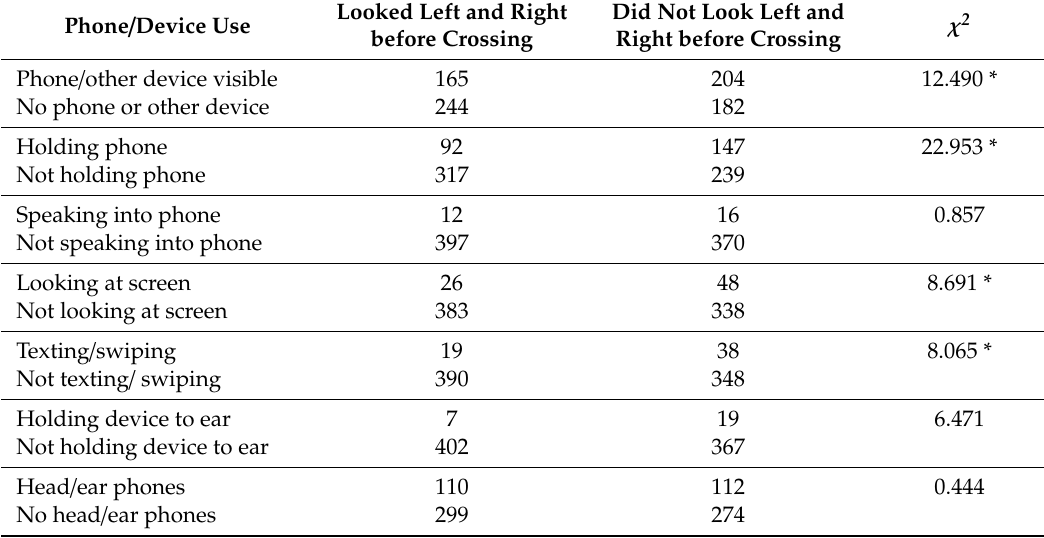
Table 1. Use of electronic devices in relation to road-crossing behaviours—looked before crossing (number of road crossings).